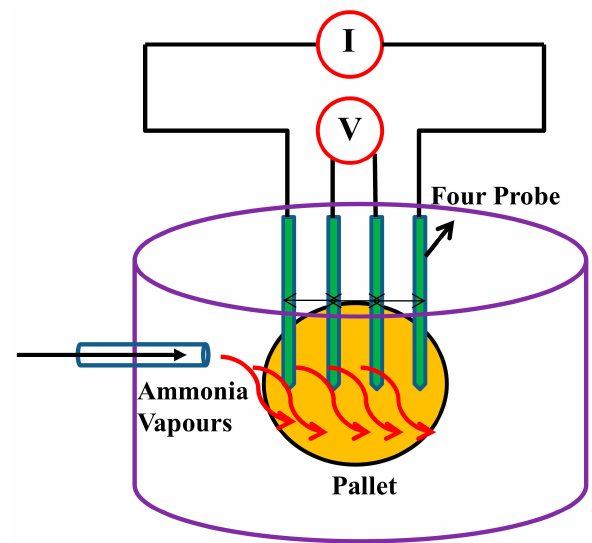
Figure 4. Ammonia sensor unit by the four in-line probes